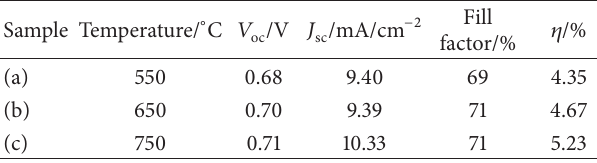
Figure 12: The DSSC percentage efficiency versus temperature for all samples. Table 4: Dye-sensitized solar cell parameter data for all